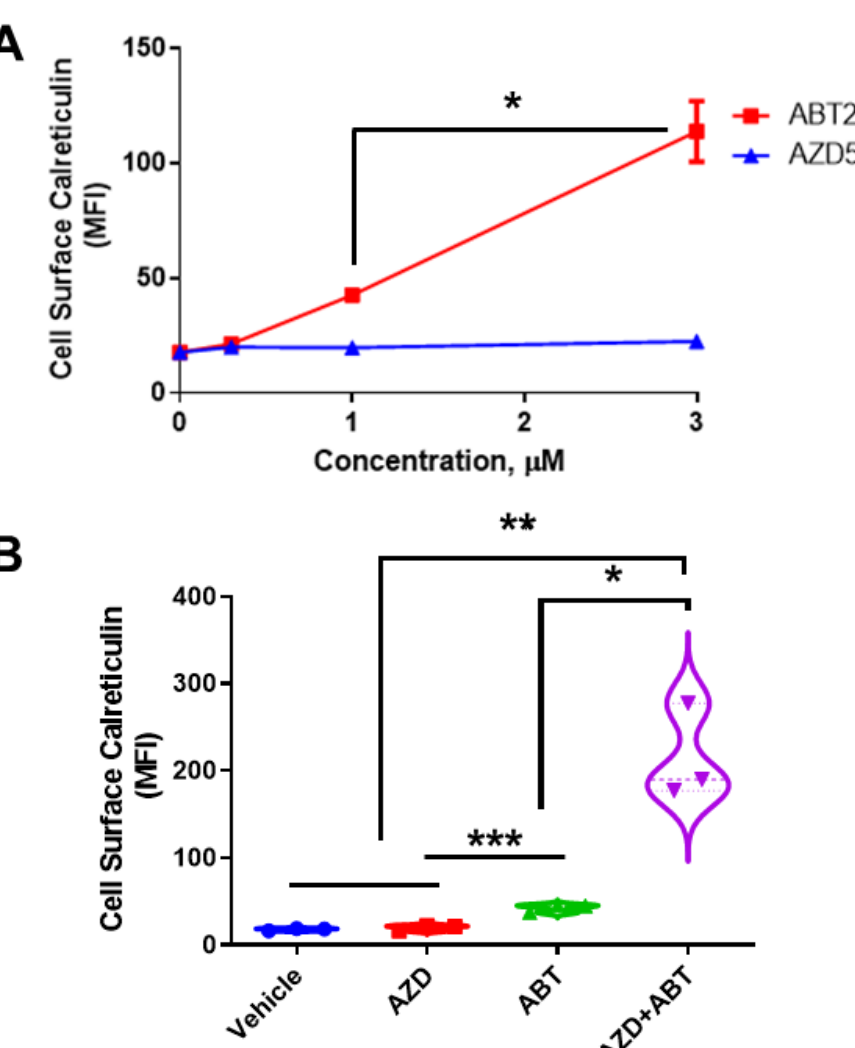
Figure 1. AZD enhances ABT263-induced CRT in DLD-1 cells. ( A ). Surface exposed CRT (ectoCRT) mean fluorescence intensity (MFI) was determined in vehicle treated (DMSO) DLD-1 cells or cells treated with ABT or AZD for 24 h, at the indicated doses, ( n = 3). Statistical analysis was performed using one-way ANOVA followed by Tukey’s multiple comparison test. (* , ** , ***) Asterisks indicate significant changes as reported in results section. ( B ). Surface exposed CRT was determined in untreated (DMSO) DLD-1 cells or cells treated with either ABT (1 µ M) or AZD (1 µ M) alone or in combination (0.5 µ M each) for 24 h, ( n = 3). Statistical analysis was performed using one-way ANOVA followed by Tukey’s multiple comparison test. (*) Asterisks indicate significant changes as reported in results section. * p ≤ 0.05, ** p ≤ 0.01, *** p ≤ 0.001 .